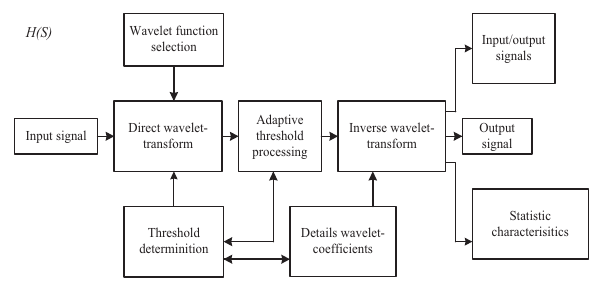
Figure 4. Block diagram of adaptive wavelet signal processing